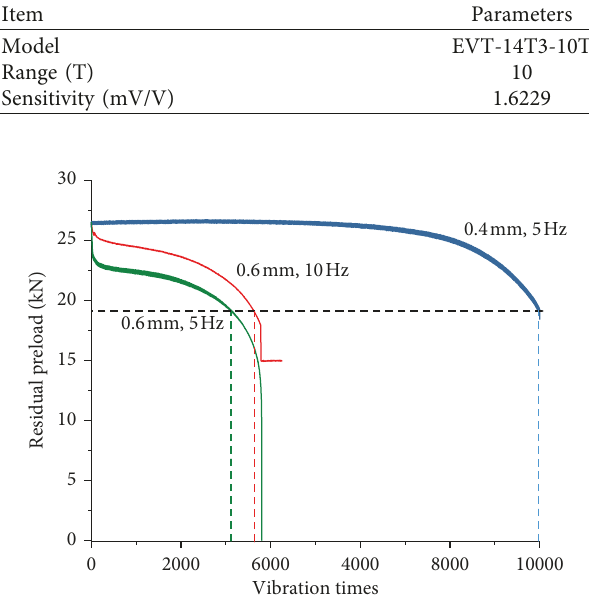
Figure 6: Loosening curves of two groups of contrast experiment.